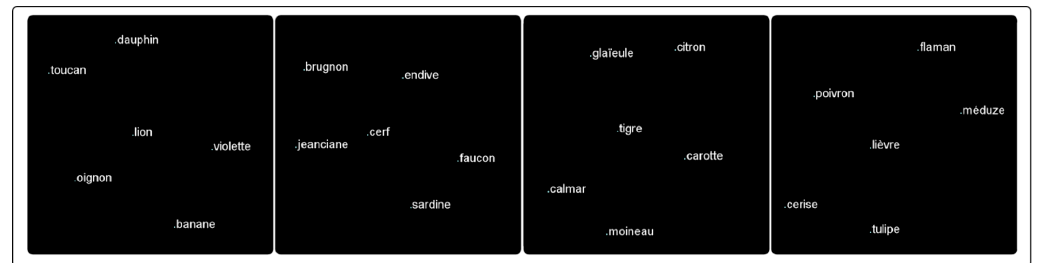
Figure 2. Example of four maps using the same map elements based on a rotation of the configuration. The translation of the names can be found in Table 1.